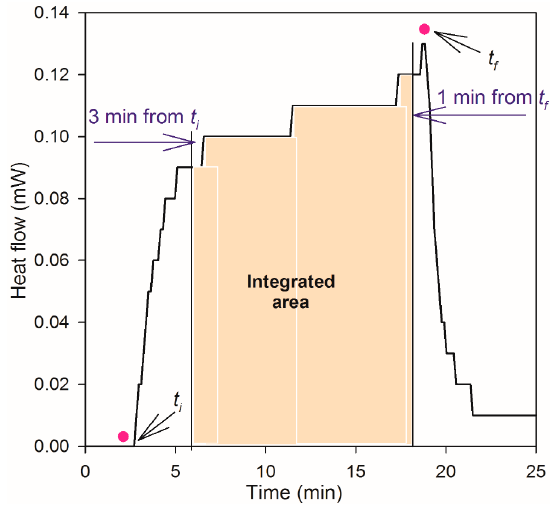
Figure 3. Details for the integrated area of adsorption heat during the first 30 min of the first NO exposure for NO TPD at 100 °C for 2 wt. % Pt/Al 2 O 3 catalyst.